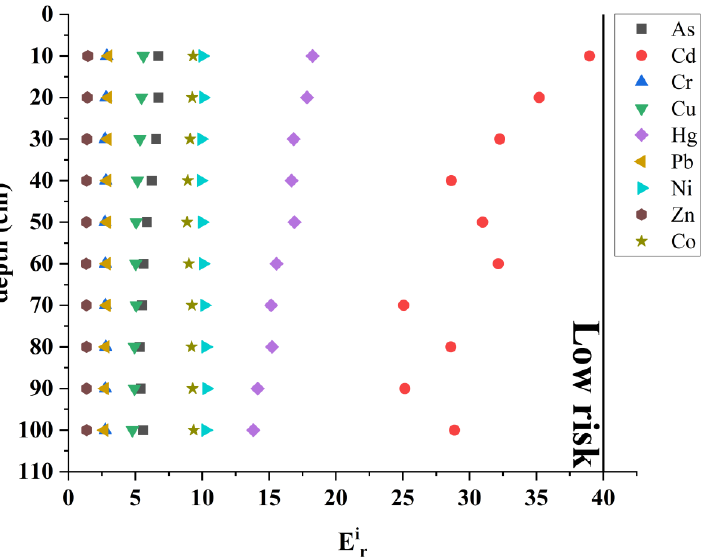
Figure 8. The result of the individual potential ecological risk index (E i r ) of each heavy metal element at each layer within 0 – 100 cm in the wetland sediment.